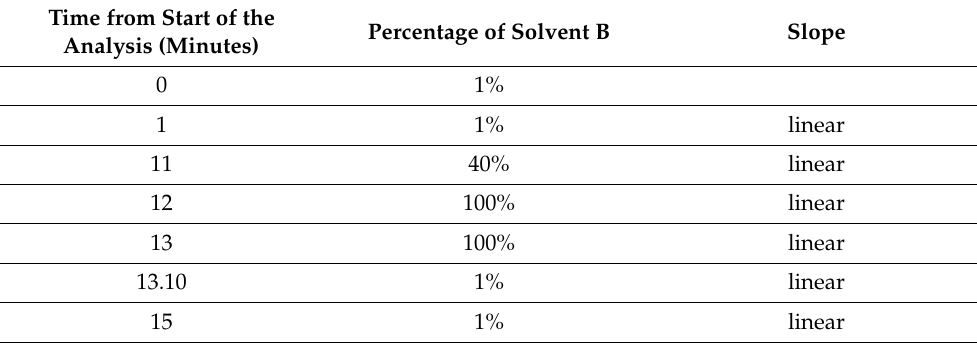
Table 1. Elution of the molecules in UPLC-DAD (Ultra Performance Liquid Chromatography-Diode Array Detection) analysis conducted by alternating gradient and isocratic phases and used for the quantification of gallic acid